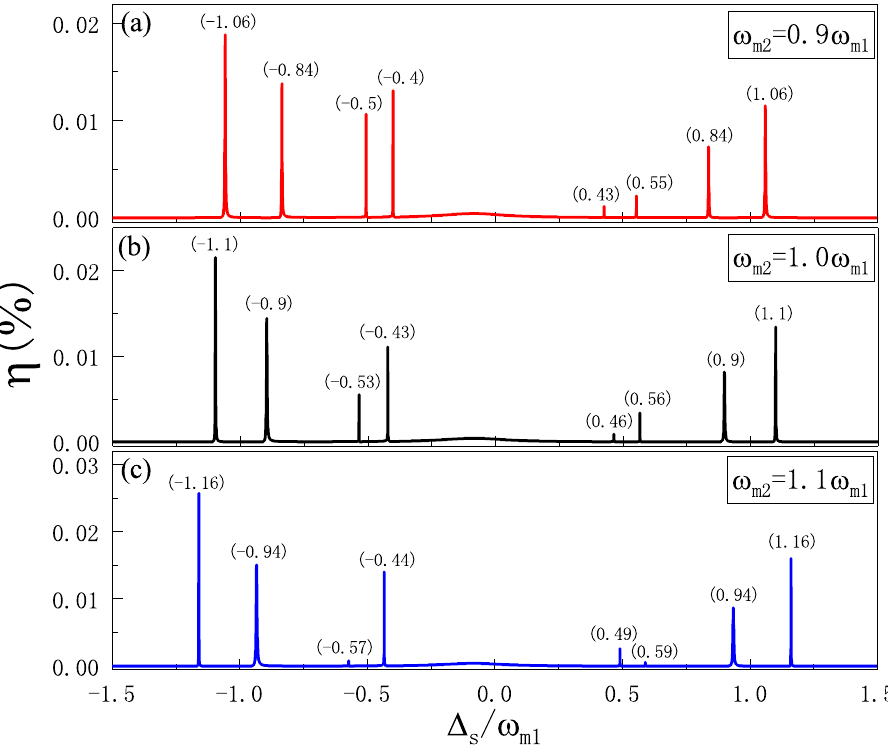
Figure 5. ( a ) The efficiency η of SSG as a function of ∆ s / ω m 1 for ω m 2 = 0.9 ω m 1 . ( b ) The efficiency η of SSG as a function of ∆ s / ω m 1 for ω m 2 = 1.0 ω m 1 . ( c ) The efficiency η of SSG as a function of ∆ s / ω m 1 for ω m 2 = 1.1 ω m 1 . The other parameters are P c = 1.5 µ W , V = 0.1 ω m 1 , and ∆ c =